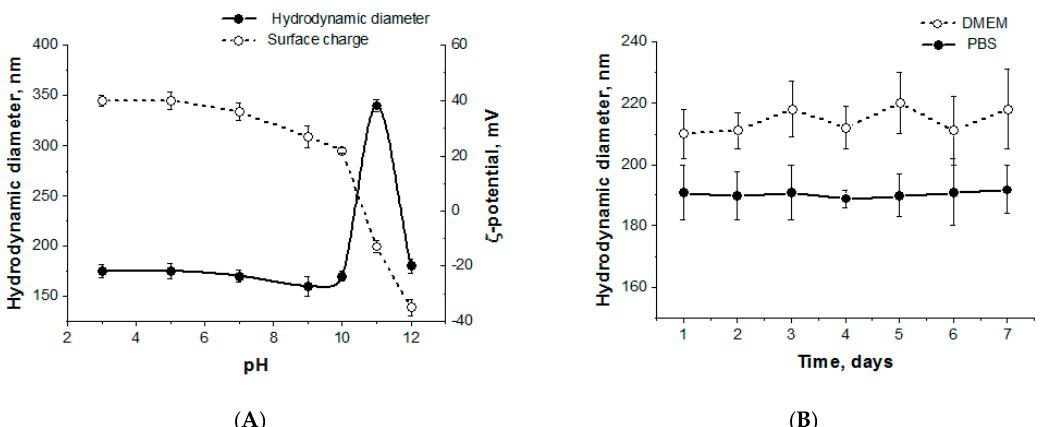
Figure 2. pH sensitivity ( A ) and stability ( B ) of polypeptide nanoparticles (sample KEI2).